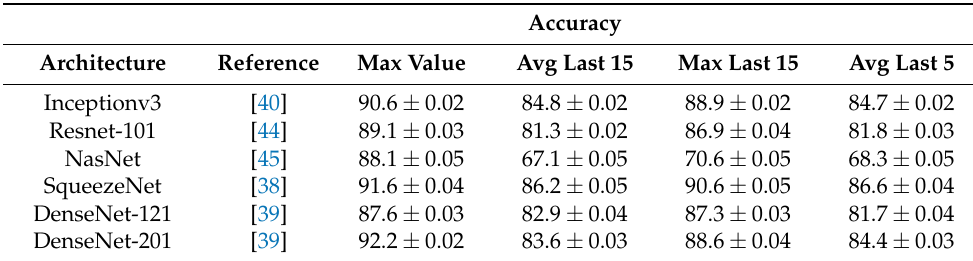
Table 1. Results regarding the learning curves, including the max value for all epochs, average for the last 15 epochs, max value for the last 15 epochs, and average for the last 5 epochs.